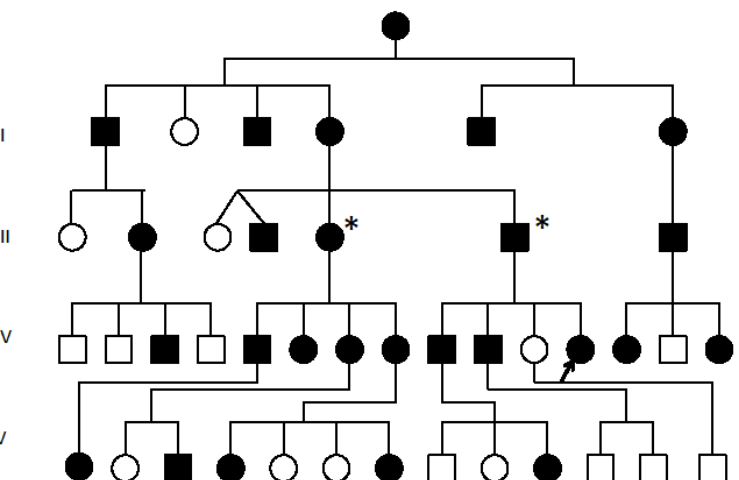
Figure 1. Pedigree of the SYNS4 family with congenital carpal tarsal coalition and progressive vertebral and ossicle joint ossification: All affected family members (filled symbols) presented with a degree of vertebral fusion and disruption of the TOSPEAK gene [17]. Nearly 50% of affected family members tested presented with bilateral fusion of carpal and tarsal joints [17]. The severity of phonological speech impairment was varied and more severe in affected males in association with ossification and malformation of laryngeal cartilages and ligaments [18]. Square symbols (Males), Circle symbols (Females), Filled symbols (Affected). Blank circles (Unaffected), Proband (Arrowed for fibroblast cell line testing), * (Fresh Blood testing for GDF6 expression).